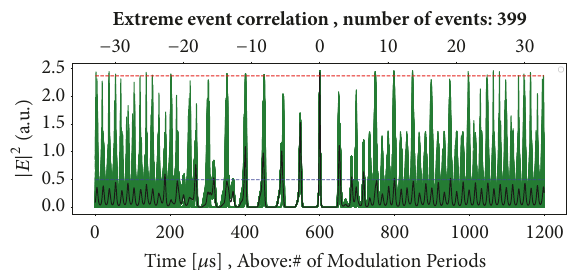
Figure 5: Intensity as a function of time in units of the modulation period using an extreme event as trigger and superposing 322